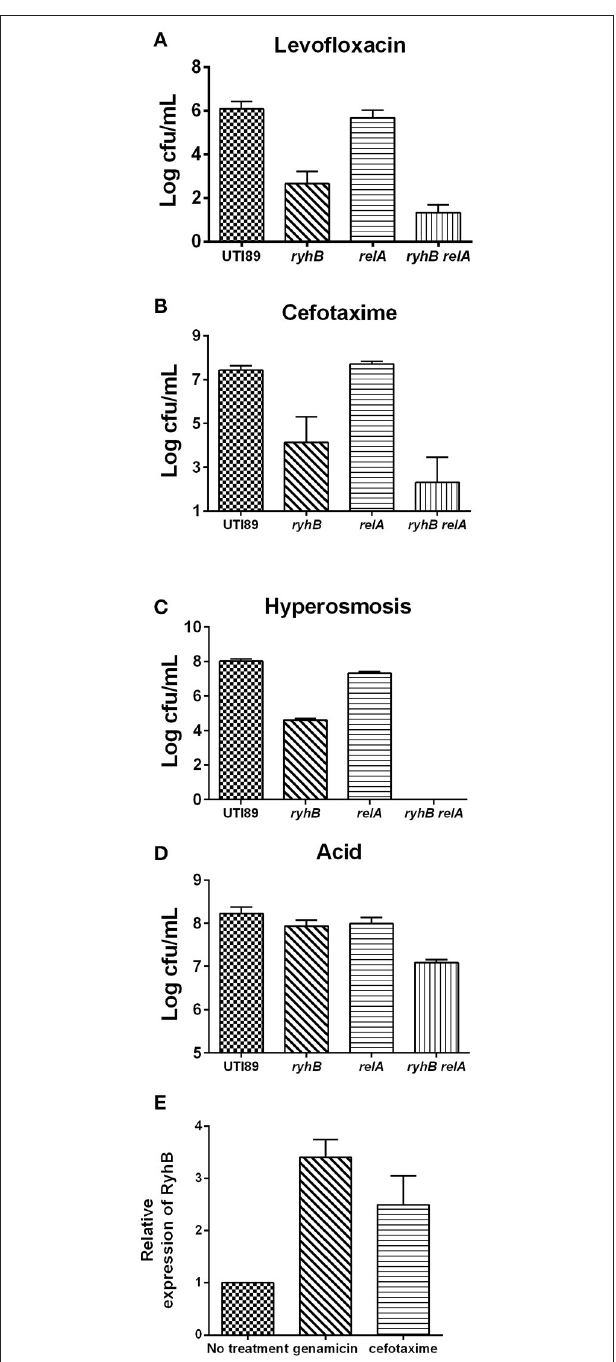
FIGURE 5 | RyhB confers persistence in a ppGpp independent manner. ppGpp mutant strain 1 relA ( relA ), double-deletion mutant 1 relA 1 ryhB ( relA ryhB ), including the parent UTI89 and RyhB mutant strain 1 ryhB ( ryhB ), were grown to stationary phase ( ∼ 10 9 CFU/mL). Exposure pressures and incubation times are shown. (A) Susceptibilities to levofloxacin (5 µ g/mL) at day 4. (B) Susceptibilities to cefotaxime (128 µ g/mL) at day 4. (C) Susceptibilities to hyperosmosis (NaCl, 4M) at day 1. (D) Susceptibilities to acid at pH 3.0 at 3h. (E) Relative expression of RyhB in response to antibiotics. Stationary phase UTI89 bacteria were exposed to gentamicin (30 µ g/mL) and cefotaxime (128 µ g/mL) for 1 day, followed by extraction of total RNA for real-time PCR. Error bars show standard